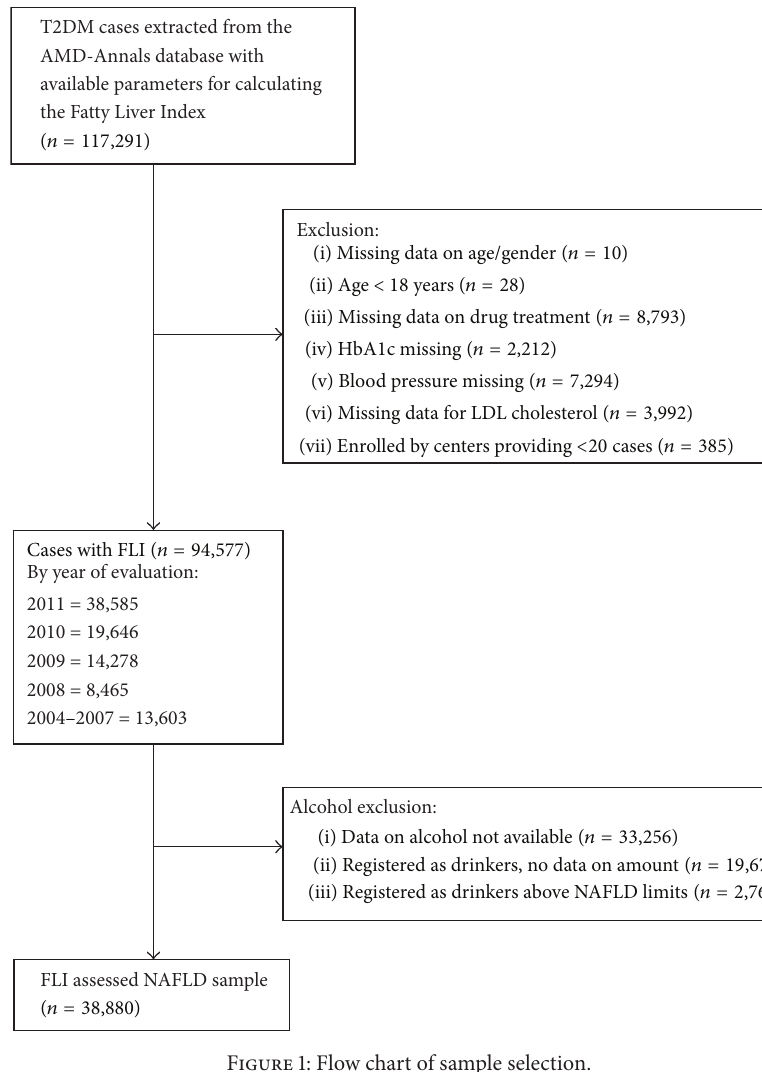
Figure 1: Flow chart of sample